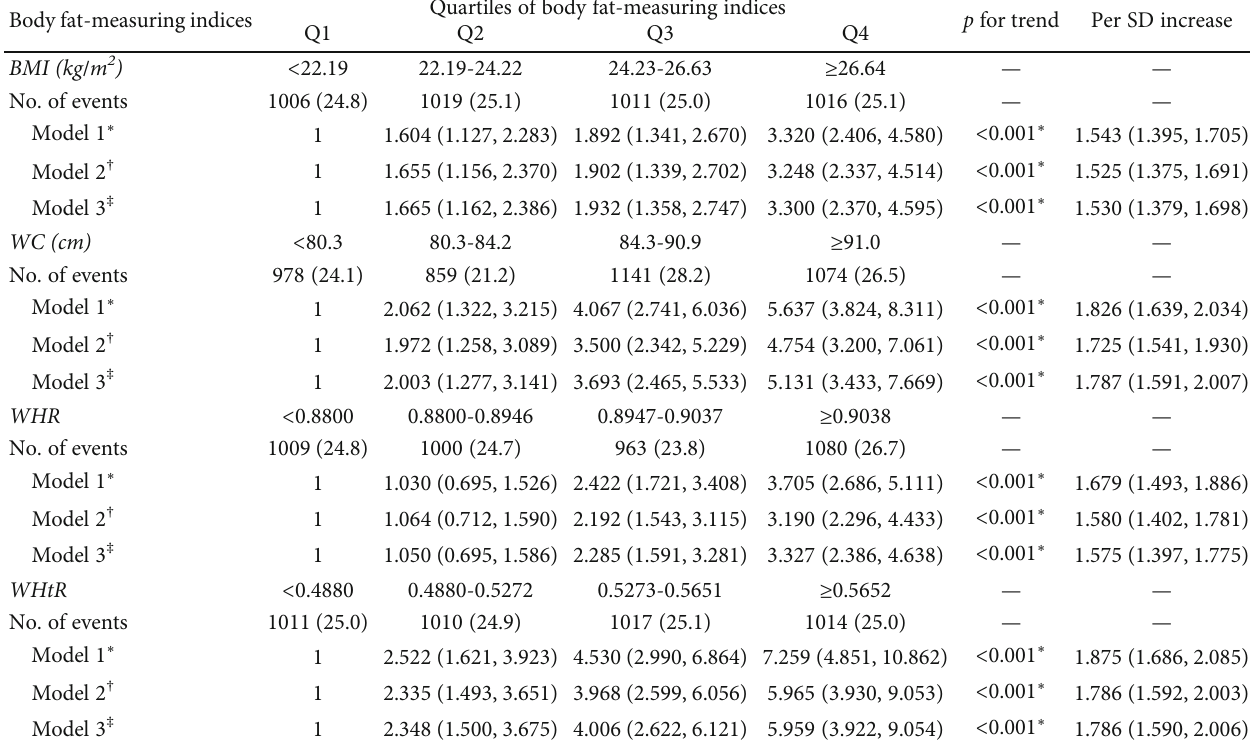
Table 2: Odds ratio (95% con fi dence intervals) for diabetes, according to the quartiles of BMI, WC, WHR, and WHtR. Quartiles of body fat-measuring indices Body fat-measuring indices